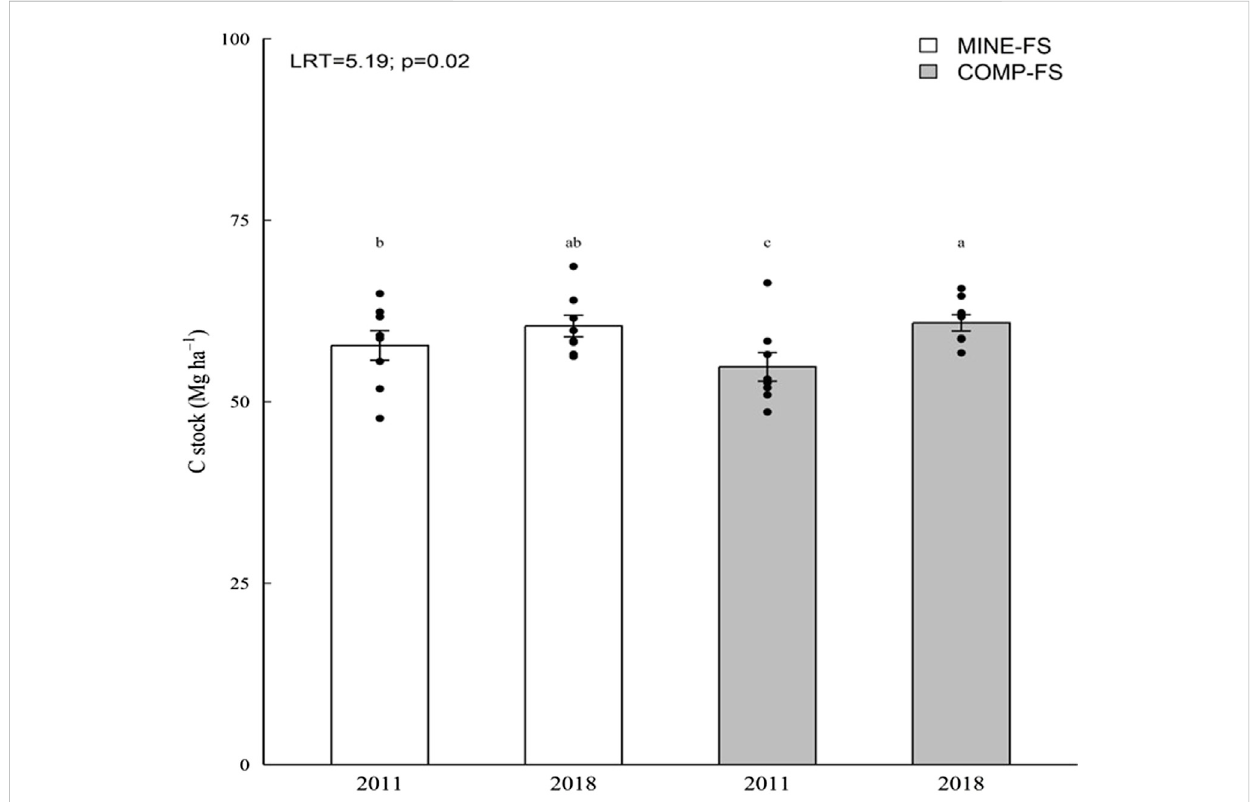
FIGURE 2 Interactive effects between fertility sources (mineral-MINE-FS and compost-COMP-FS) and years of sampling (2011 and 2018) on soil organic C stocks (C stock Mg ha − 1 ) in the 0 – 0.30 m. Data are measured mean values ±SE ( n = 8 for crop rotation schemes, fertility sources and years of sampling). Signi fi cance tests, using likelihood ratio test (LRT), are comparing models with or without the parameter of